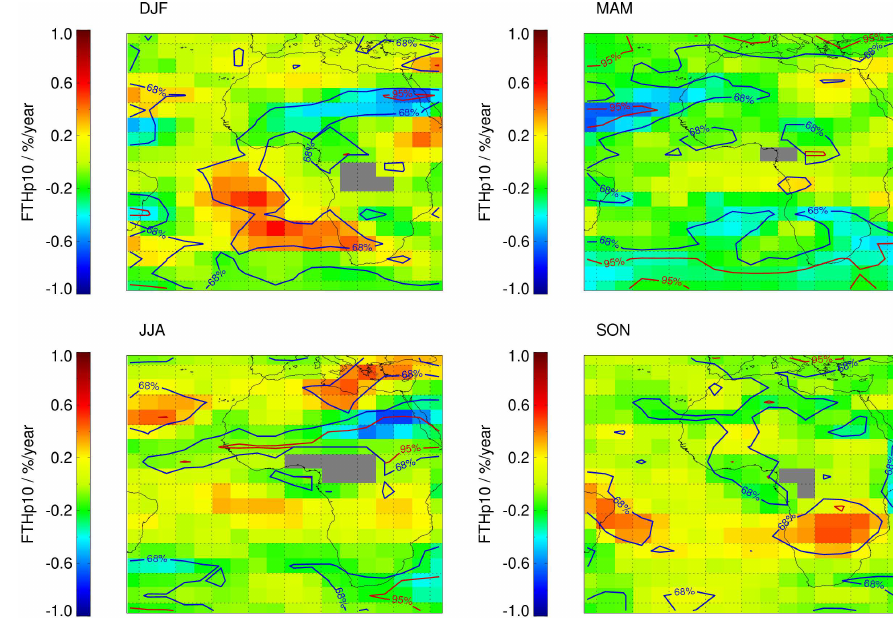
Figure 12. Same as Figure 10 but for FTHp10. 2